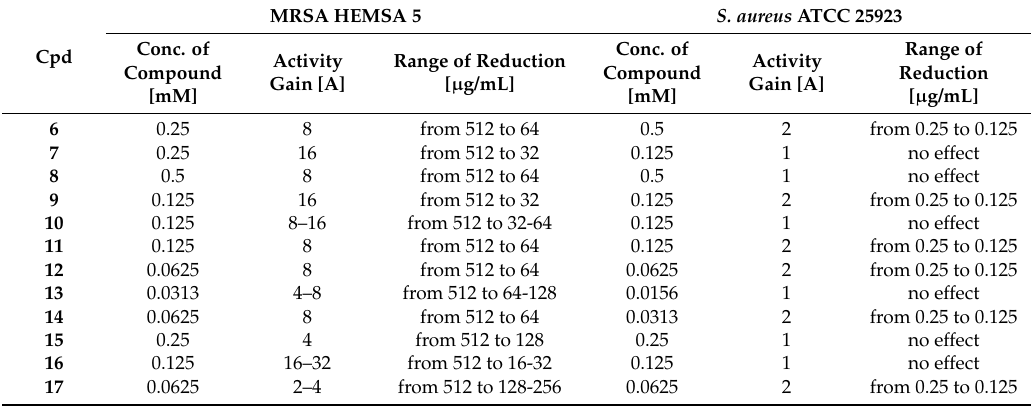
Table 5. Effect of imidazolidine derivatives on the susceptibility of S. aureus strains to